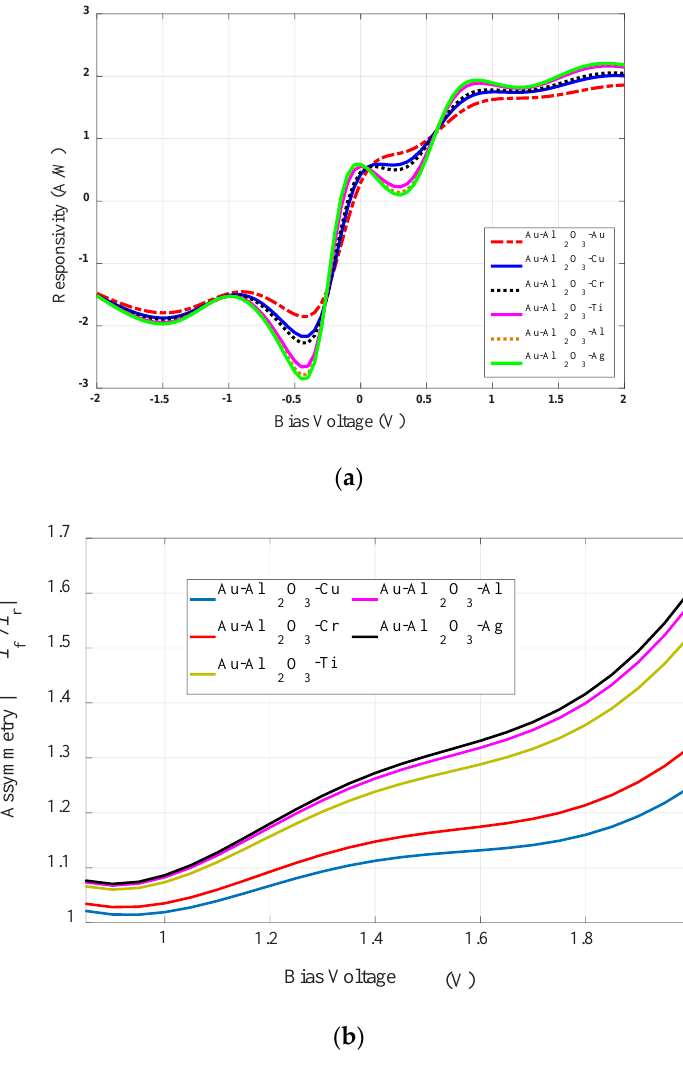
Figure 6. Variations in ( a ) the responsivity and ( b ) the symmetry characteristics with the different material configurations of the MIM-diode.